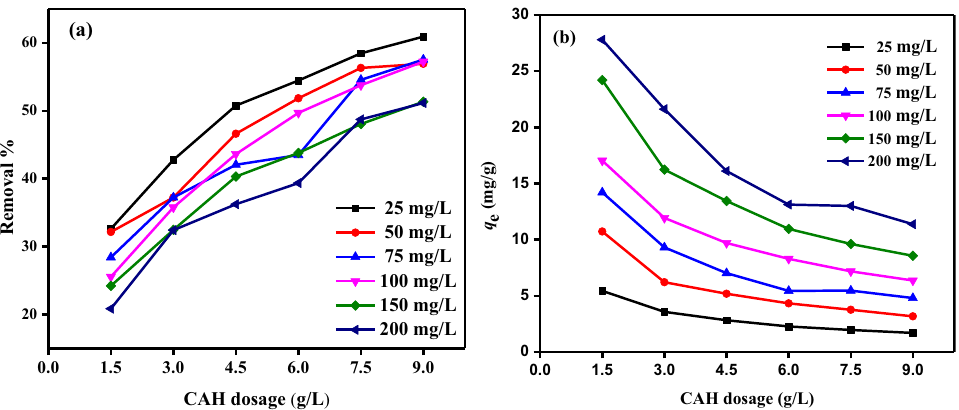
Figure 9. The influence of CAH doses (1.5–9.0 g/L) of various beginning DB86 dye concentrations (25– 200 mg/L) on ( a ) % of removal; ( b ) q e (mg/g), at temp. (25 ± 2 °C).